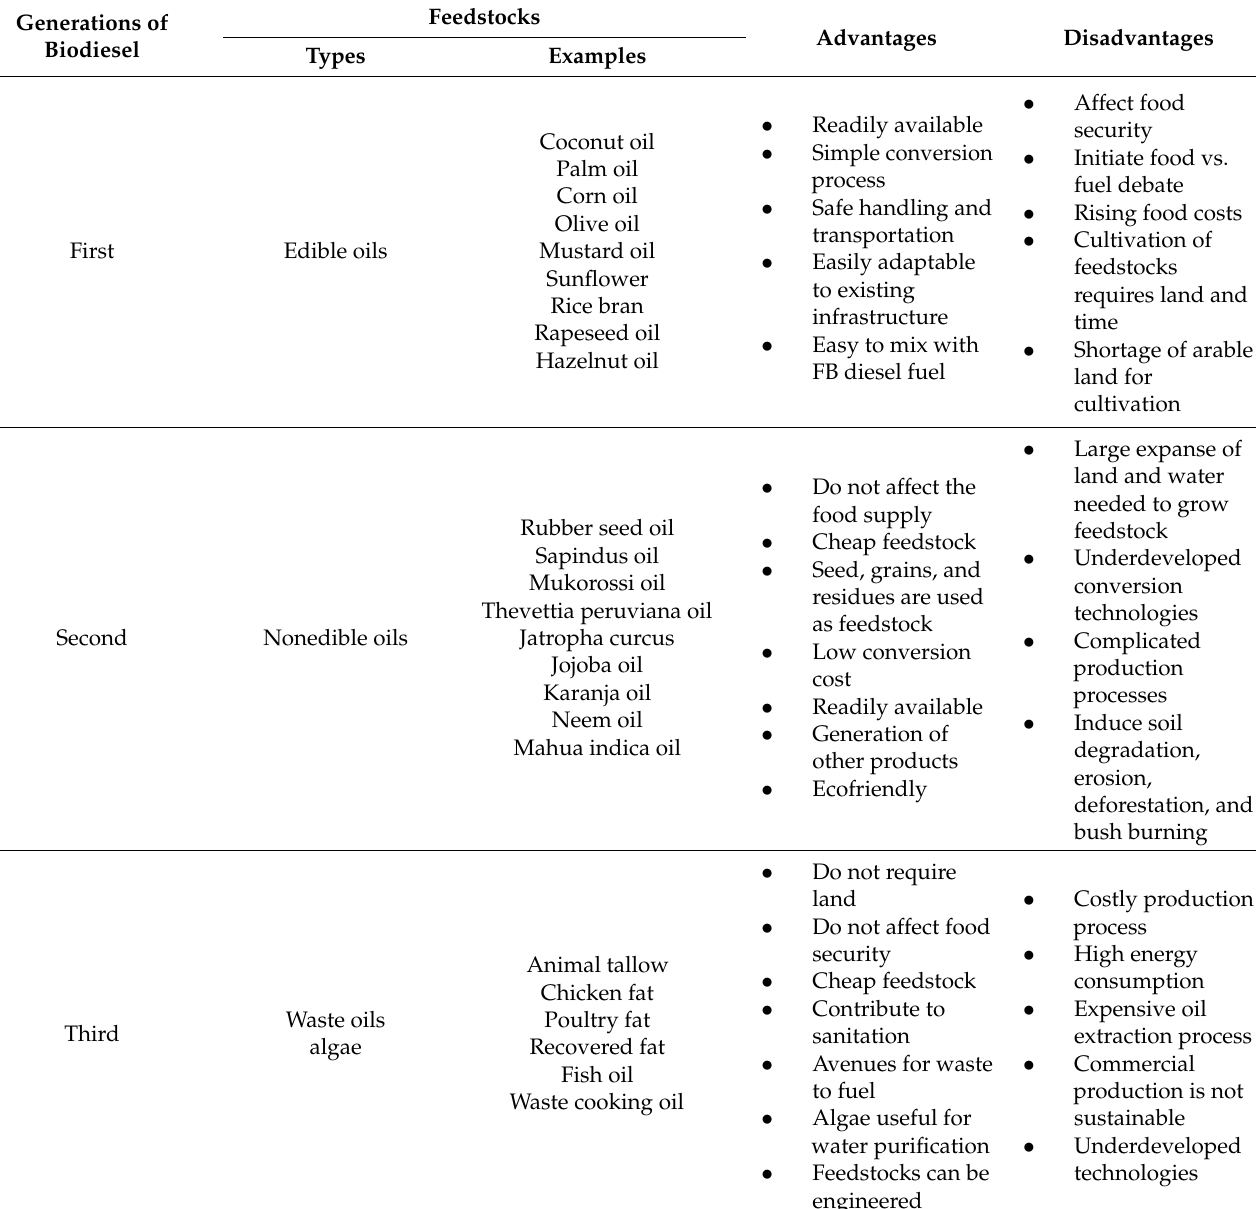
Table 2. Examples of feedstocks for the four generations of biodiesel